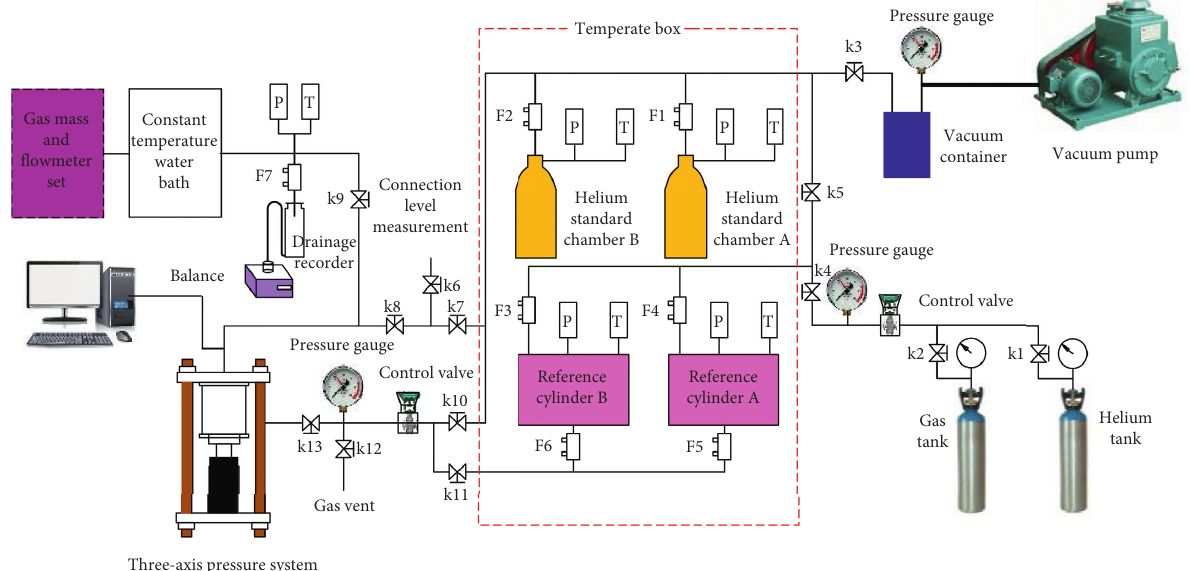
Figure 4: Test system. 1–drainage recorder; 2–balance; 3–three-axis pressure system; 4–control valve; 5–vacuum container; 6–vacuum container; 7–pressure gauge; 8–control valve; 9–gas tank; 10–helium tank.